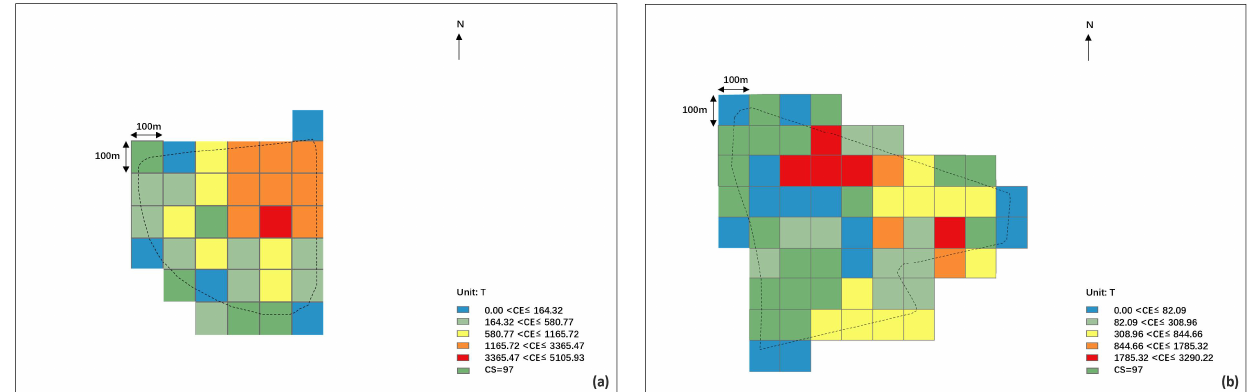
Figure 9. Areas with high carbon emissions (Visualization based on mapbox platform).